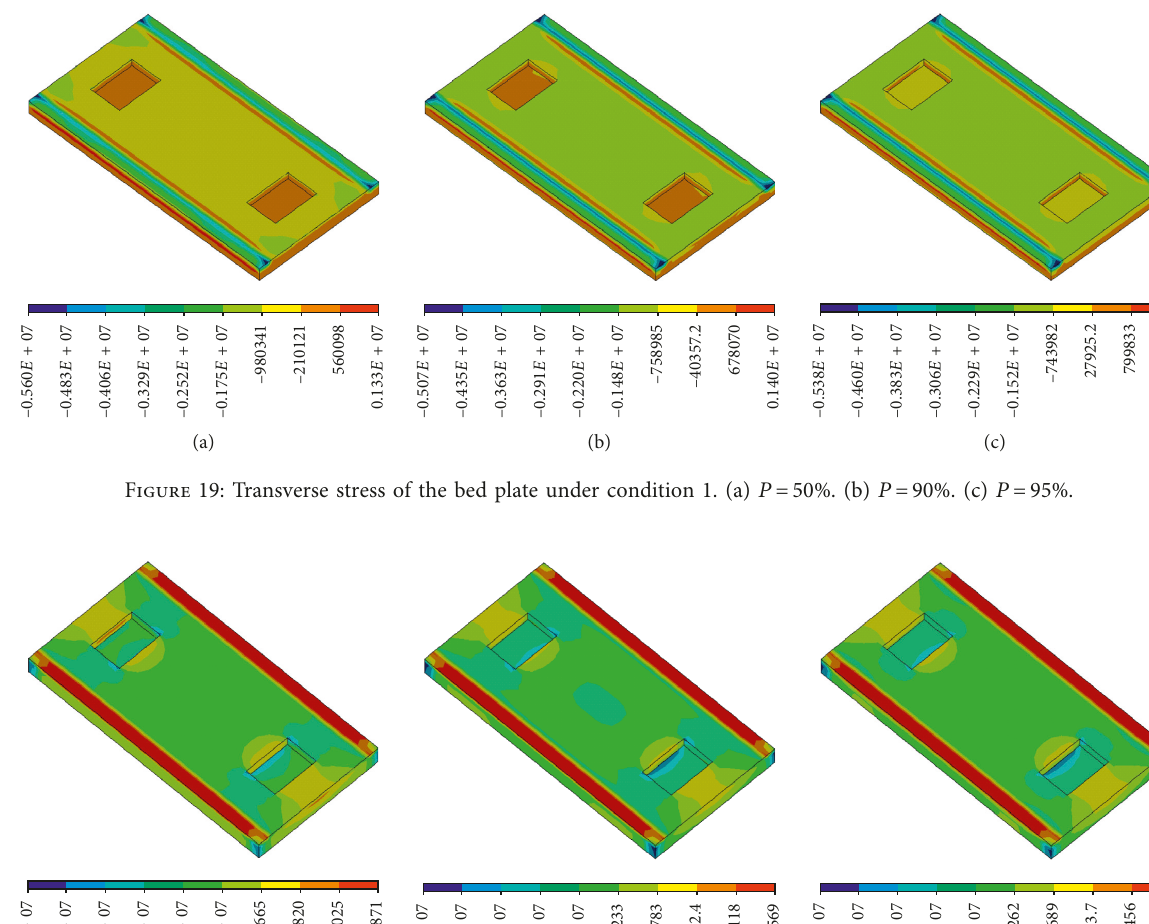
50%. (b) P 90%. (c) P 95%. (cid:31) (cid:31) (cid:31)